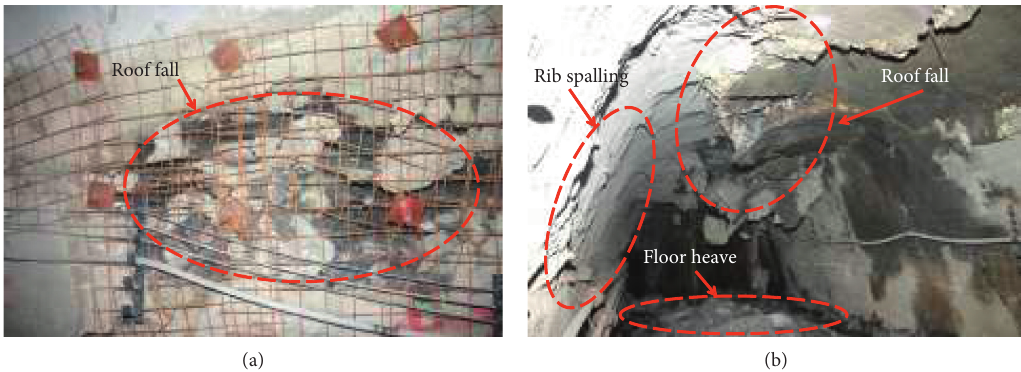
Figure 1: Deformation failure cases in the roadway. (a) Roof falling. (b) Floor heave, rib spalling, and roof